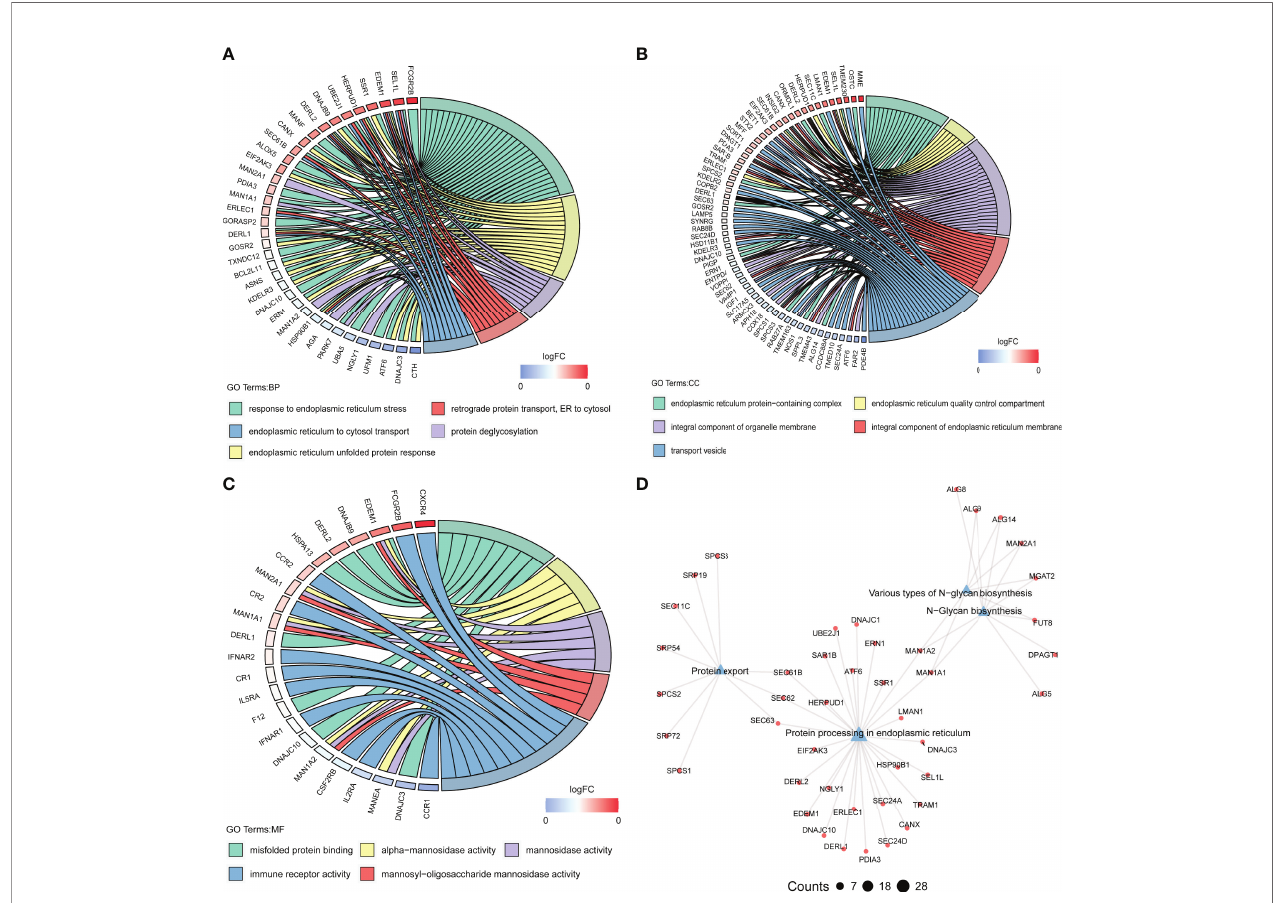
FIGURE 8 | Biological functions behind the pink module. (A – C) GO-BPs (A) , GO-CCs (B) , and GO-MFs (C) enriched in the pink module. GO, Gene Ontology; BP, biological processes; CC, cellular components; MF, molecular functions. (D) Kyoto Encyclopedia of Genes and Genomes (KEGG) pathways enriched in the pink module. The terms with p -value <0.05 are